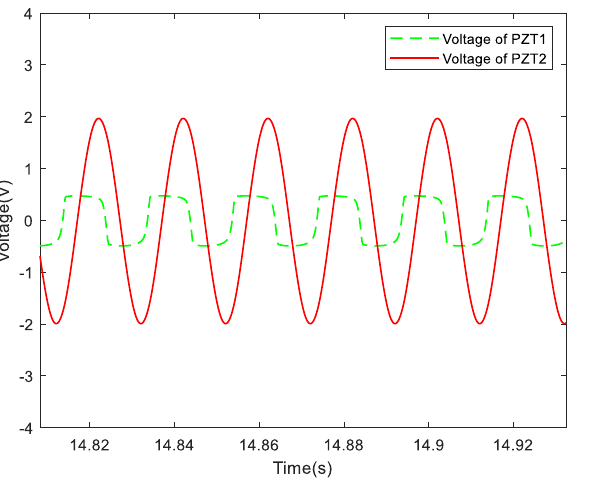
Figure 21. Displacement response (piezo-patch 2) and voltage response (piezo-patch 1) with SSDI shunt (50 Hz).